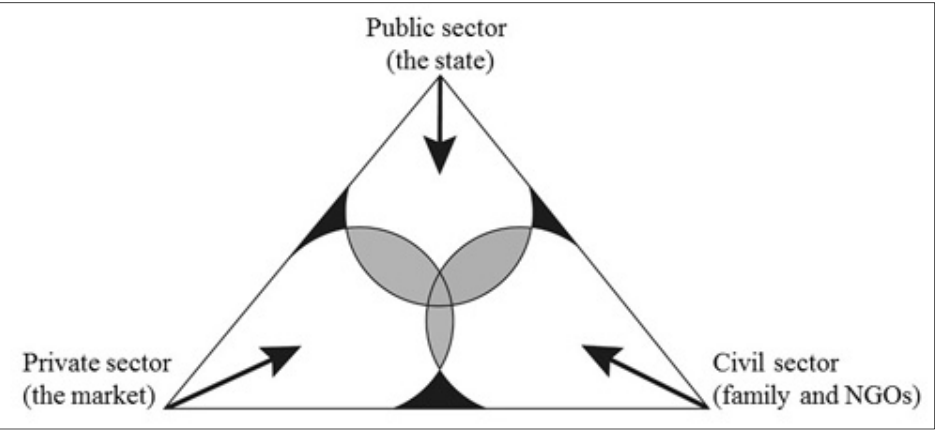
Figure 1. The welfare